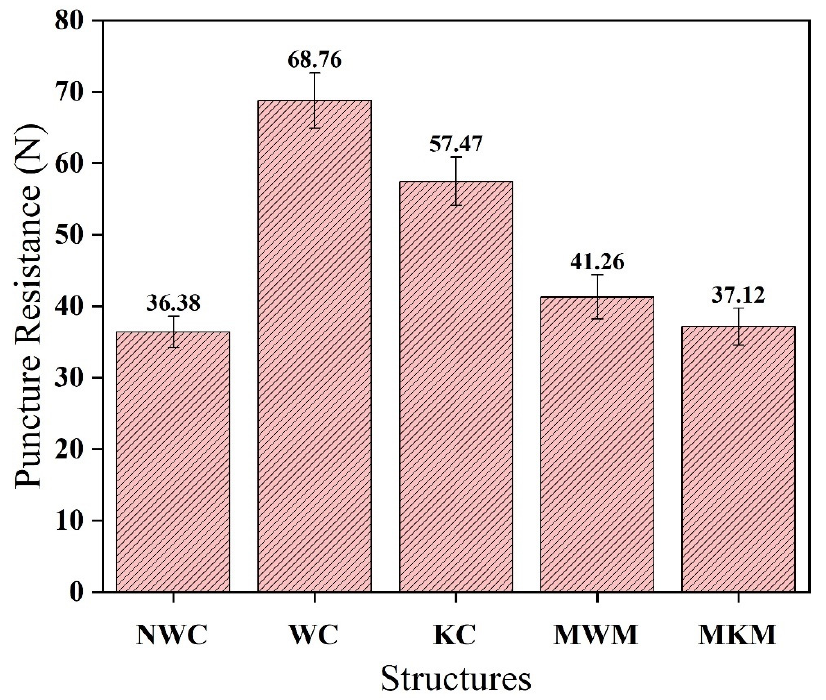
Figure 16. Comparison of puncture resistance of composites developed against reference meshes .